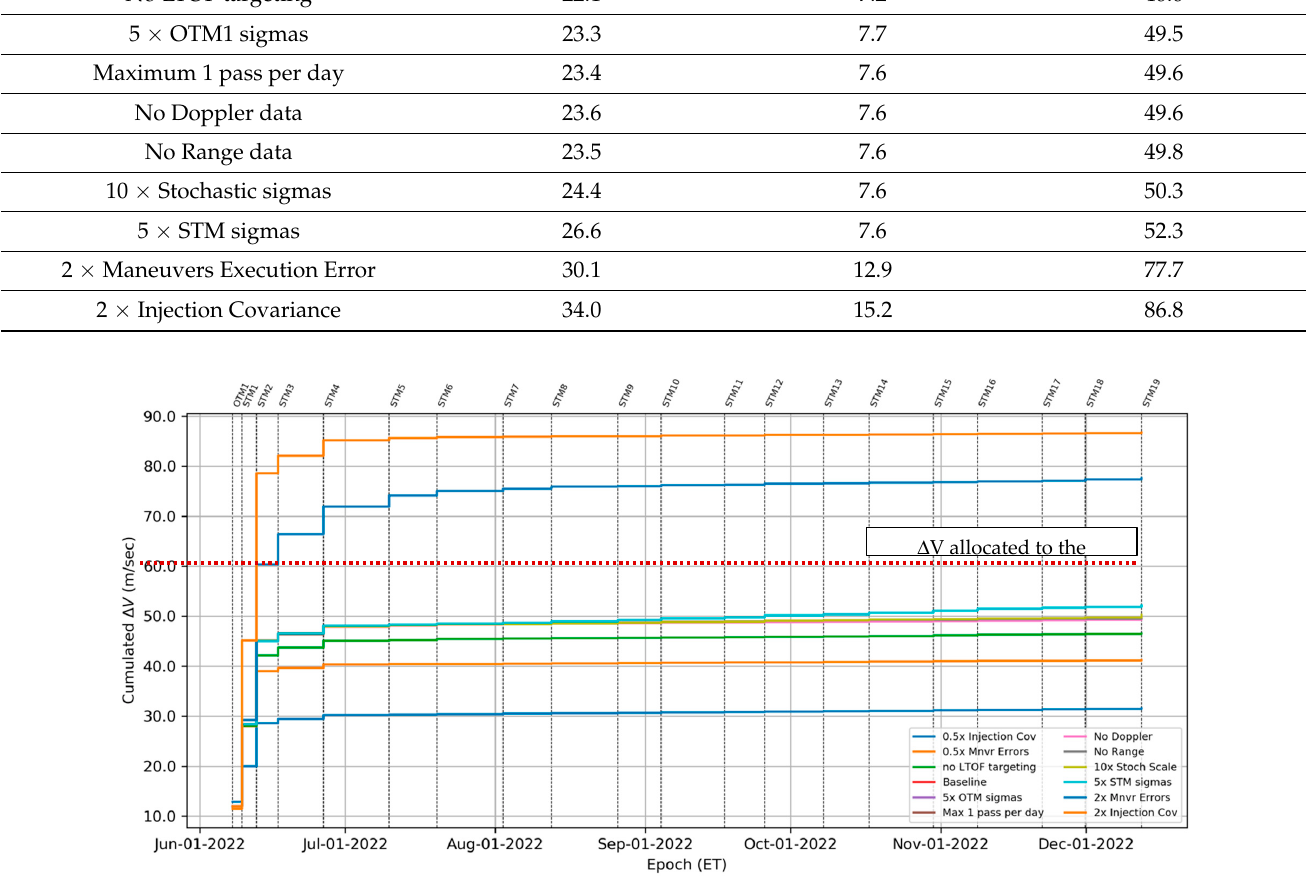
Figure 16. Full mission cumulated ∆ V statistics plot for each FPC relevant sensitivity case.